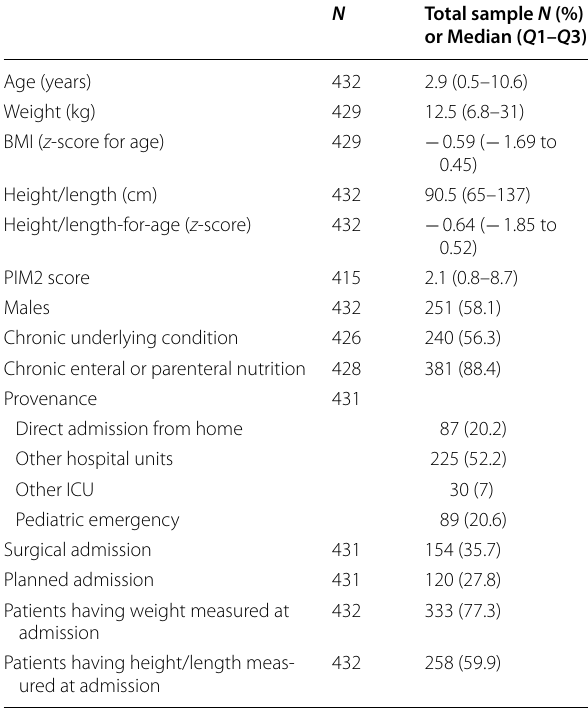
Table 3 Patients’ characteristics ( n